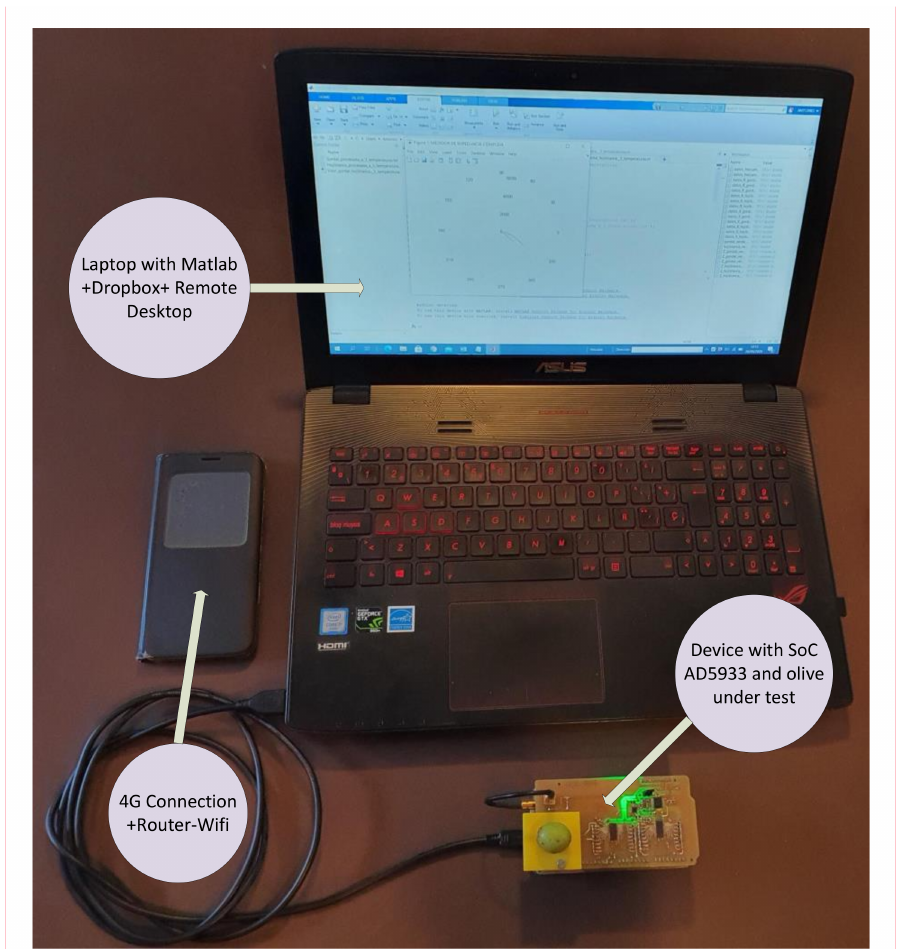
Figure 15. IoT System during test in